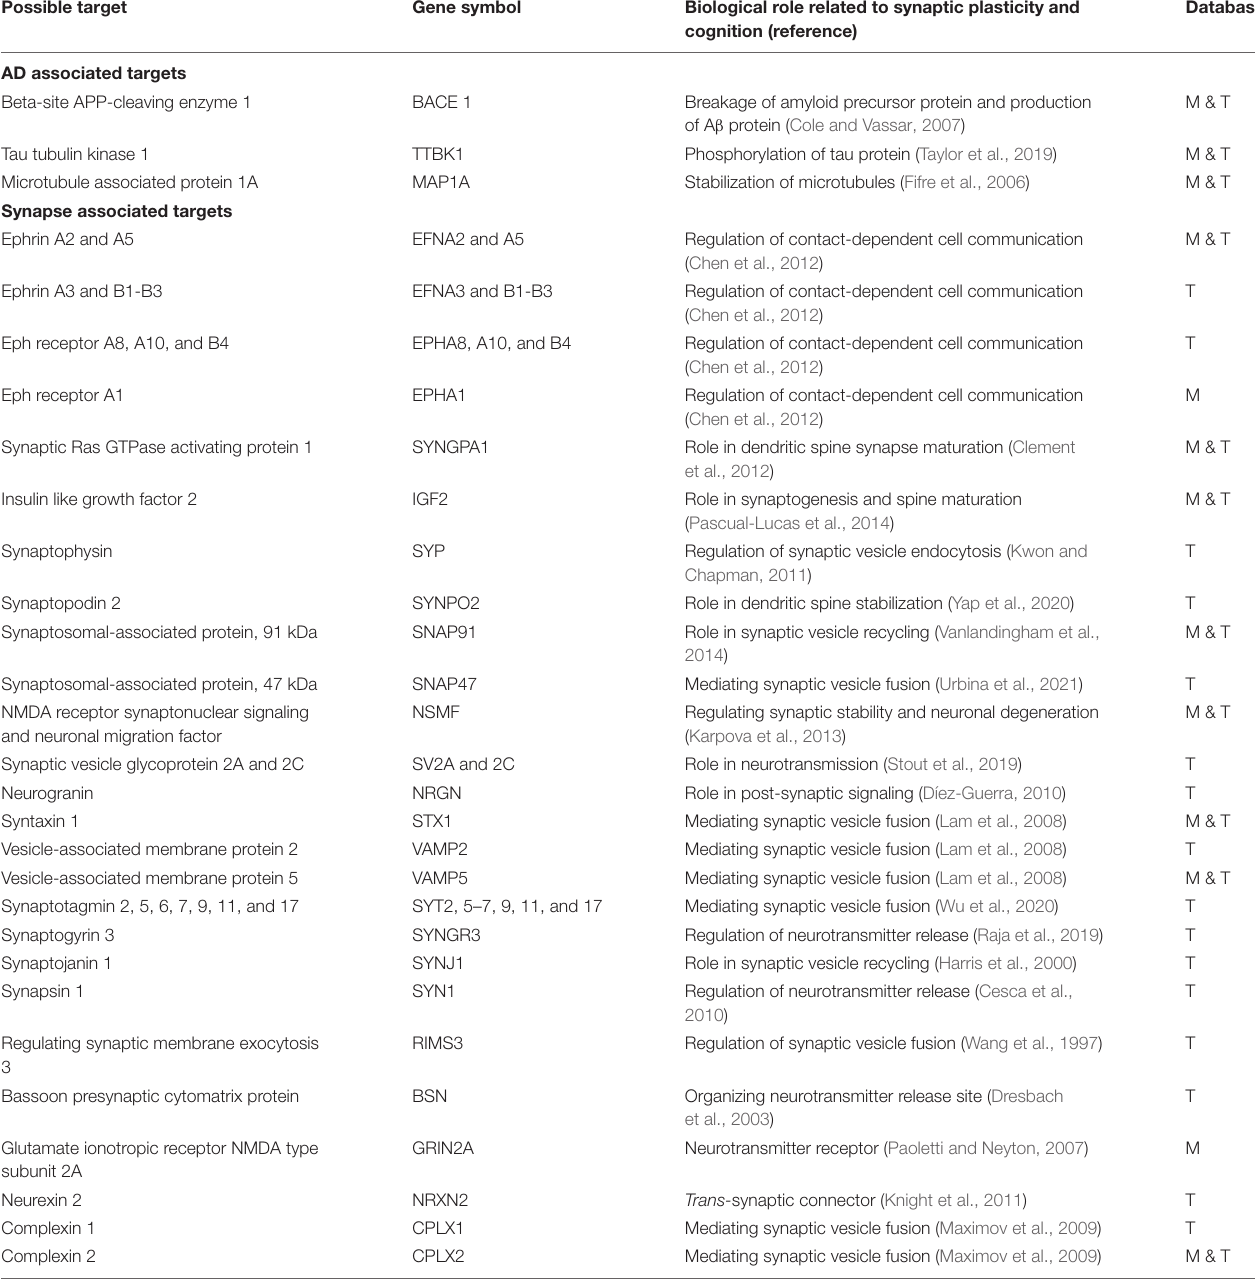
TABLE 2 | Possible target genes of miR-342-5p found in miRDB and TargetScan databases that are associated with AD or synaptic plasticity. Possible